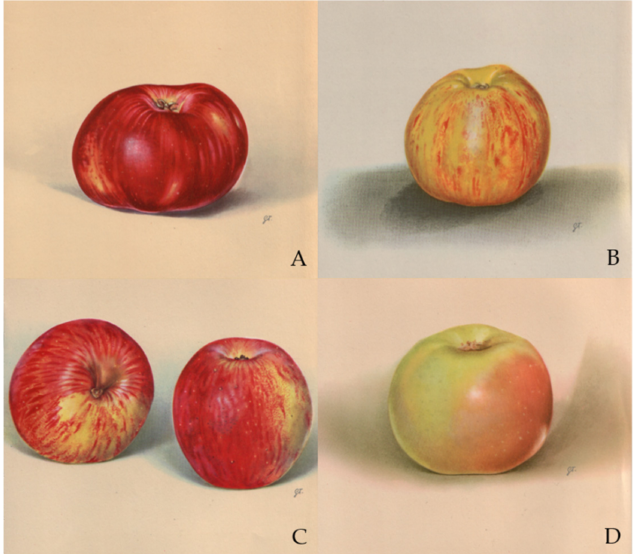
Figure 1. Old apple cultivars ‘Roter Pogatscher’ (‘Boži´cnica’) ( A ), ‘Blumen Calvill’ (‘Grafenštajnka’) ( B ), ‘Großer Rheinischer Bohnapfel’ (‘Bobovec’) ( C ), and ‘Grüner Stettiner’ (‘Zeleni štetinec’) ( D ) (This is a painting by a Croatian artist Greta